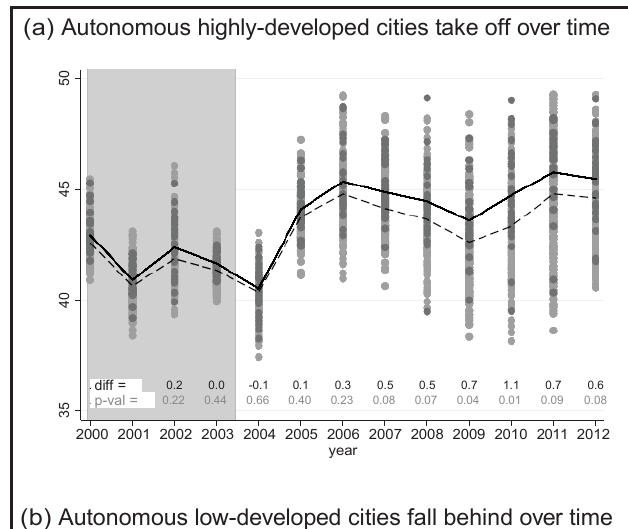
Figure A3 Evolution of test scores for the two groups of cities over time. Notes: The figure shows the evolution of test score averages over time. Autonomous cities are solid, nonautonomous ones are dashed; highly developed cities are darker, and low-developed ones are lighter. In subfigures (a) and (b) at the bottom, differ- ences between the postreform gap and the pre-reform (2001) gap are indicated ( H 0: diff = 0). Pre-reform and transition years are shaded in